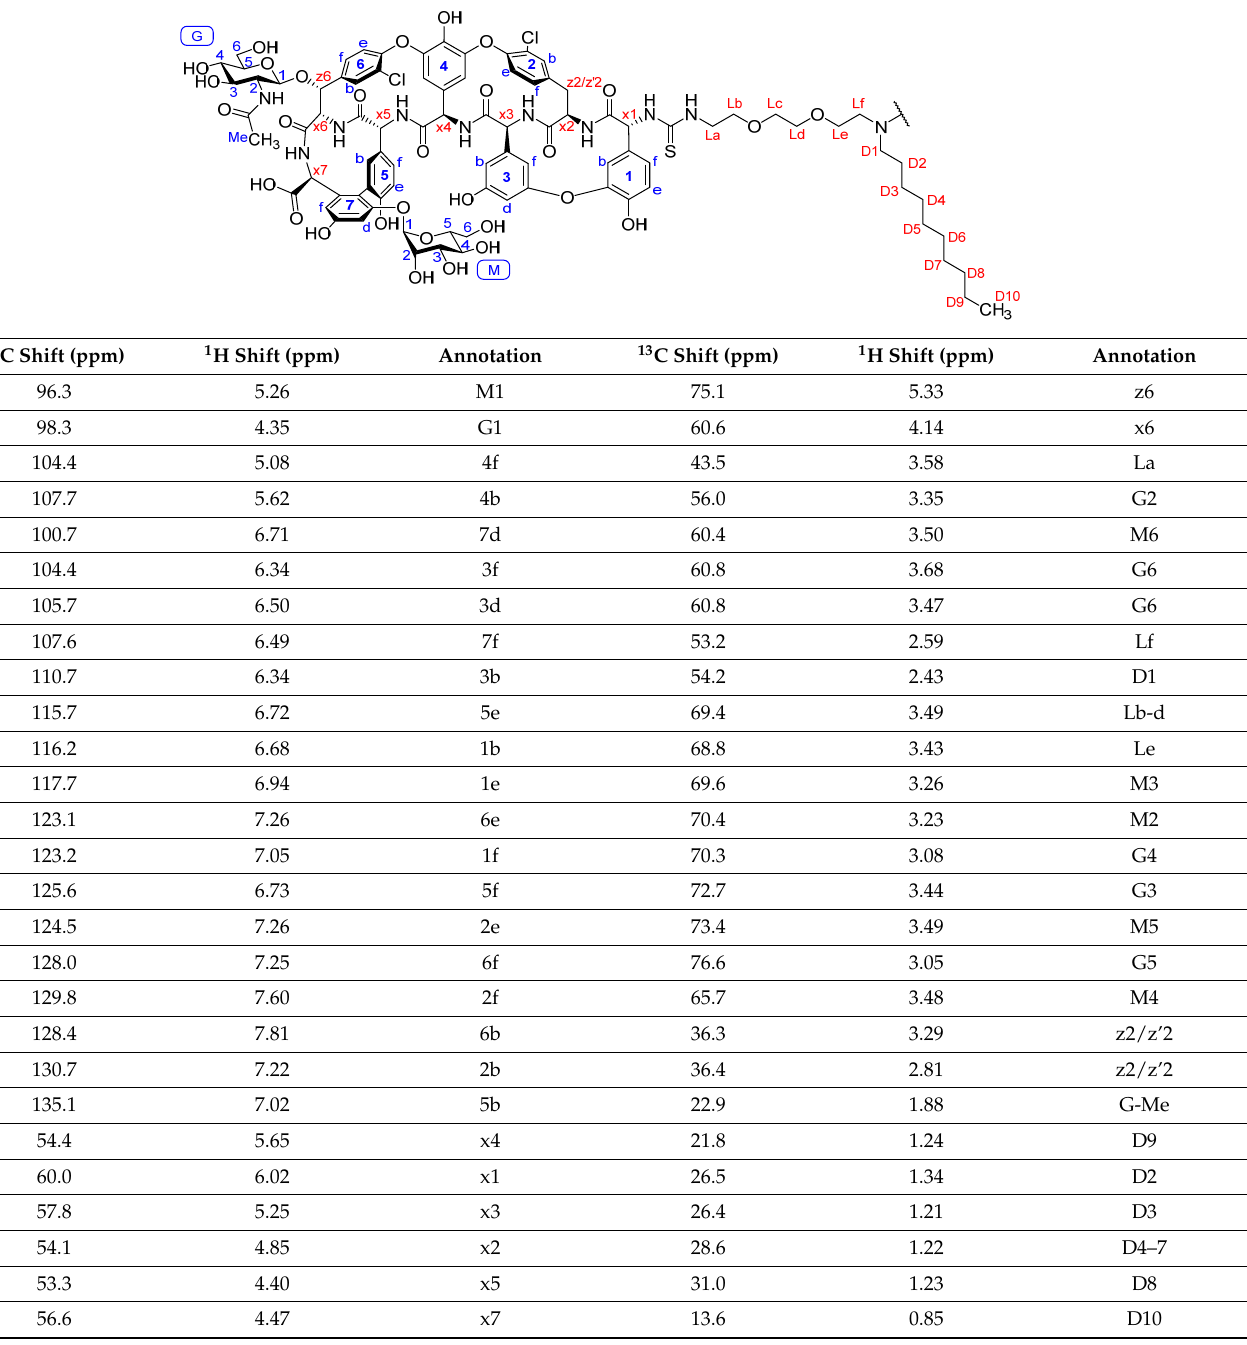
Table 2. NMR data of 12 .